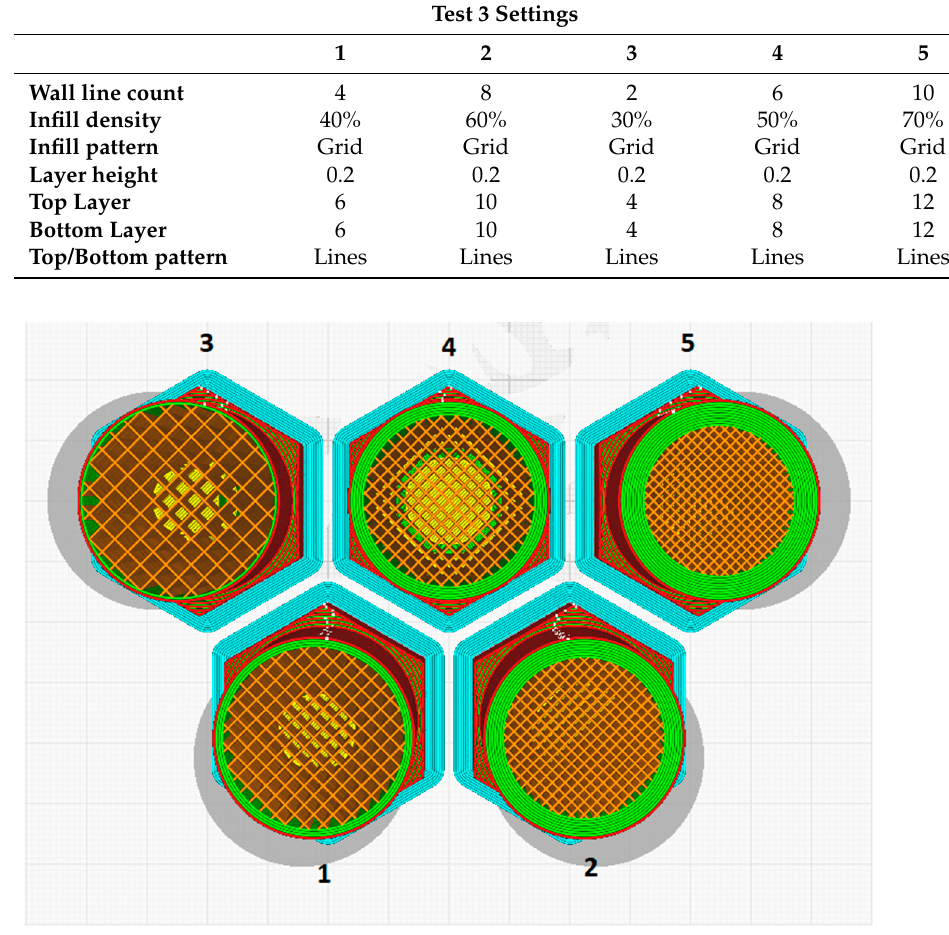
Figure 7. Punch settings of Test 3.